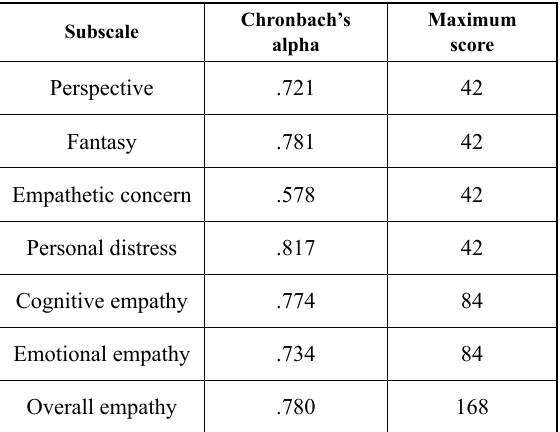
Table 1. Internal reliability of subscales of Interpersonal Reactivity Table 2. Internal reliability of subscales of Revised